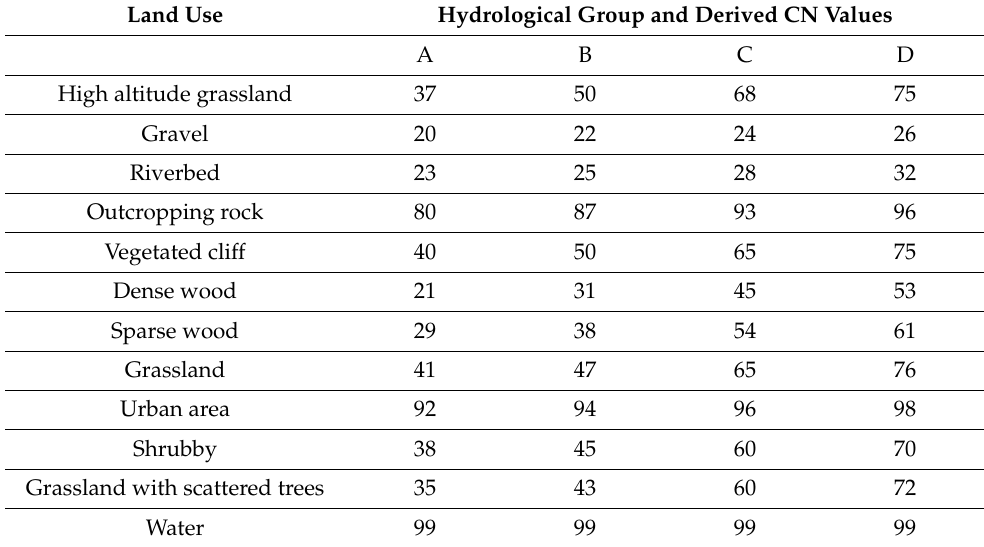
Table 2. CN values determined by the intersection of land use units and hydrological groups, deriving from the application of CN standard values, modified from [30,31]. Land